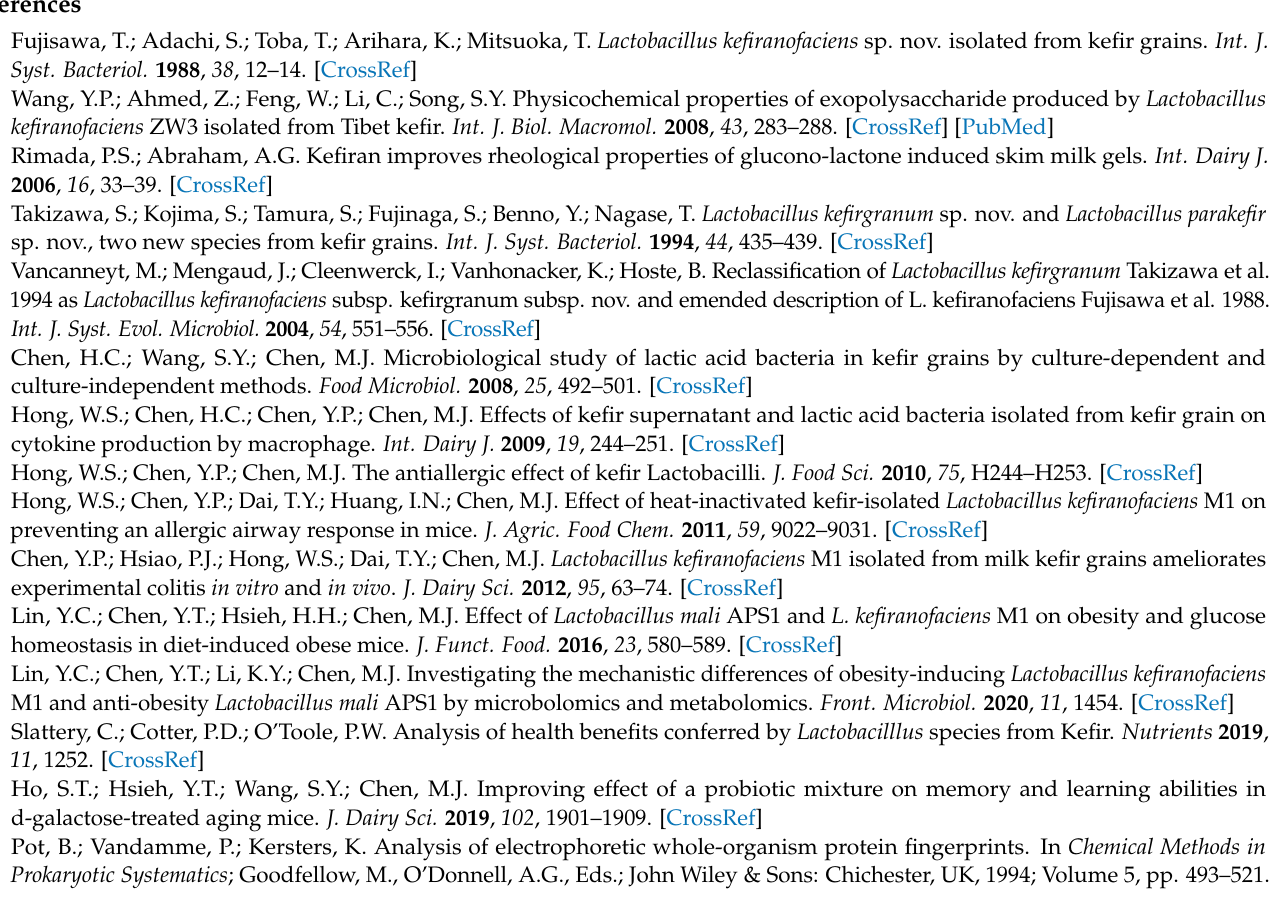
kefirgranum HL1 and M1. Phylogenetic tree based on housekeeping gene sequences [(A) pheS and (B) rpoA ]. Figure S4. Phylogenomic tree based on whole genome sequences of L. kefiranofaciens strains and their closely related species. Figure S5. The unique genes in L. kefiranofaciens subsp. kefirgranum strain HL1 as comparing with strain M1 by MAUVE. Table S1. Oligonucleotide primer used in the PCR amplification. Table S2. Average nucleotide identity (ANI) values and digital DNA-DNA hybridization (dDDH) prediction values between HL1 and M1 with their reference strains. Table S3. Comparison of SEED subsystem features of L. kefiranofaciens strains. Table S4. Annotation of EPS genes of L. kefiranofaciens HL1 and M1 by RAST and NCBI. Table S5. Annotation results of the glycogen metabolism gene cluster by RAST and